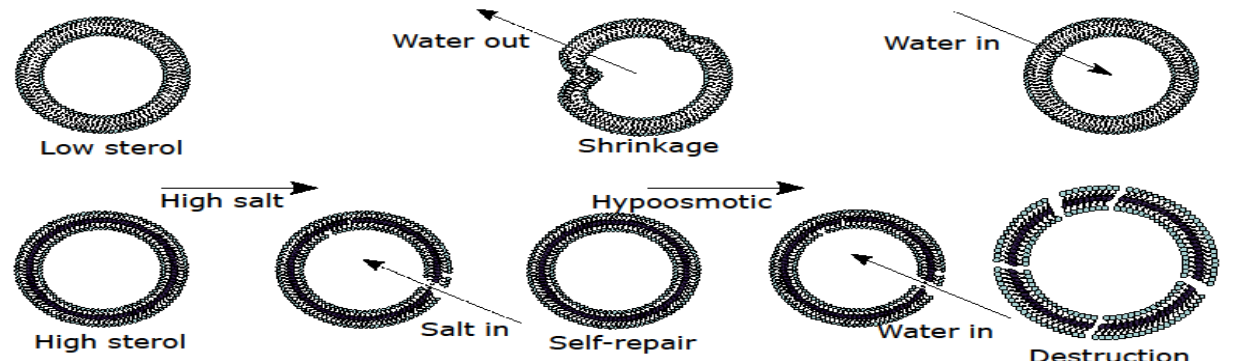
Figure 1. A scheme illustrating how sterol might provoke the pore formation upon changes in the osmotic pressure. High rigidity and low water permeability provided by high sterol might prevent the volume decrease upon high salt stress. In the case the hyperosmotic stress is followed by the hypoosmotic one, sterol-rich structures appear to be prone to rupturing. See text (Introduction) for